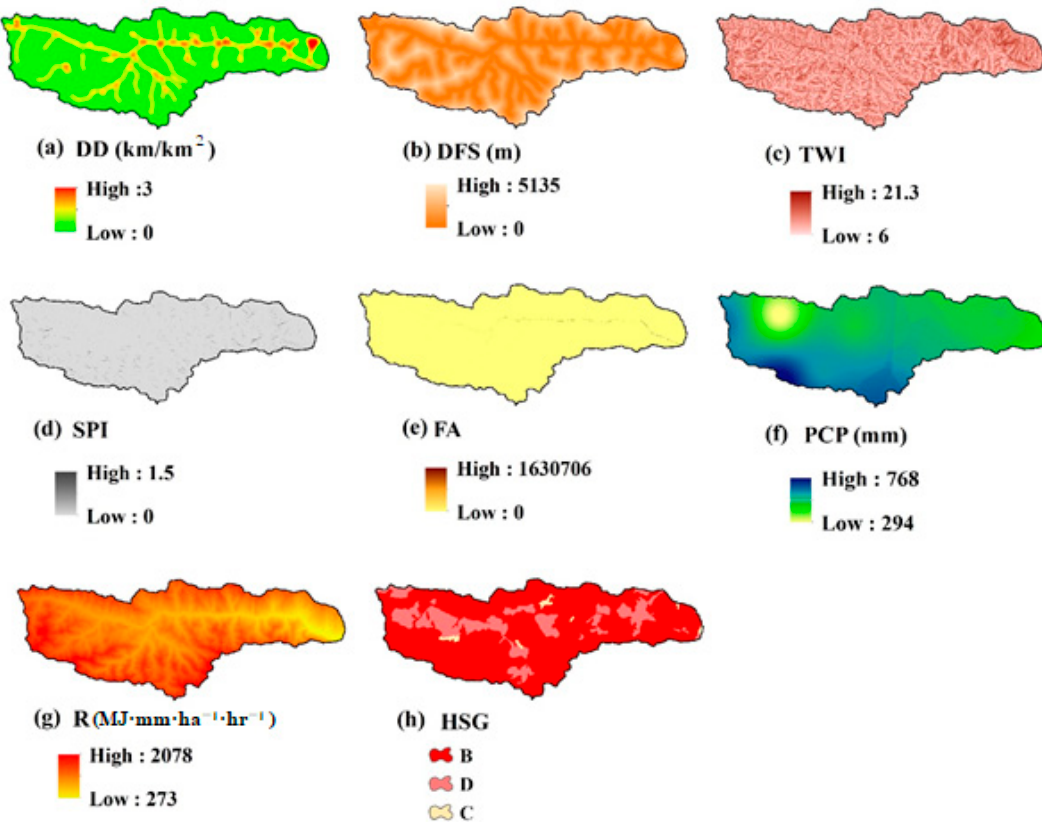
Figure 4. Hydro-climate factors: ( a ) drainage density (DD), ( b ) distance from the stream (DFS), ( c ) topographic wetness index (TWI), ( d ) stream power index (SPI), ( e ) flow accumulation (FA), ( f ) precipitation (PCP), ( g ) rainfall erosivity factor (R), and ( h ) hydrologic soil group (HSG).